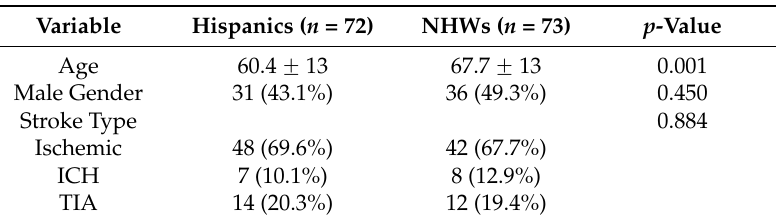
Table 1. Stroke participant